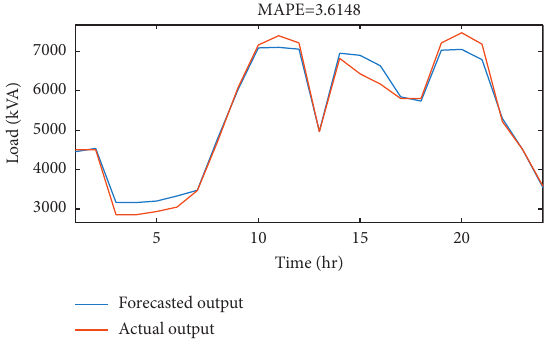
Figure 21: The Fuzzy-PSO prediction of Labor Day